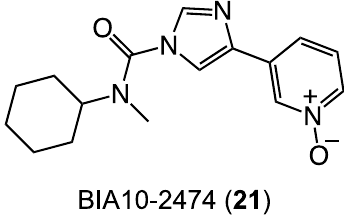
Figure 6. The 2D structure of BIA10-2474 ( 21 ).